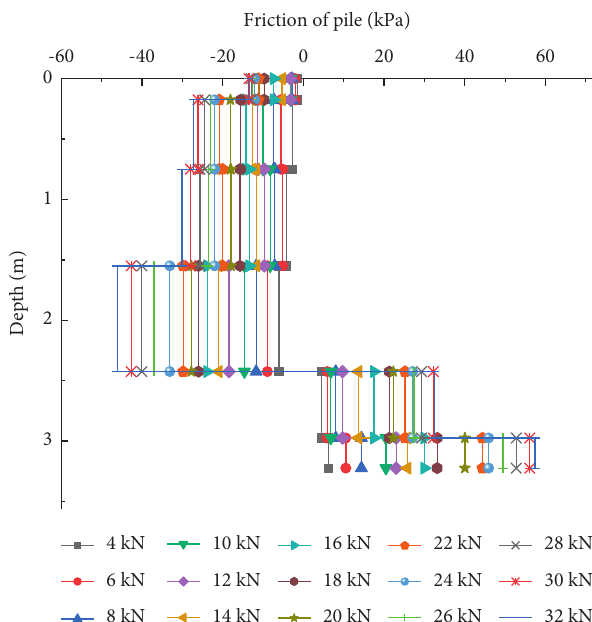
Figure 7: Distribution curve of pile friction along